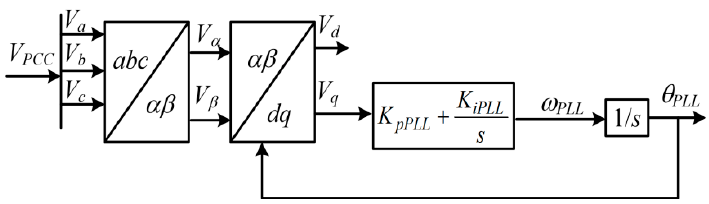
Figure 2. Schematic diagram of synchronous reference frame-phase locked loop (SRF-PLL).